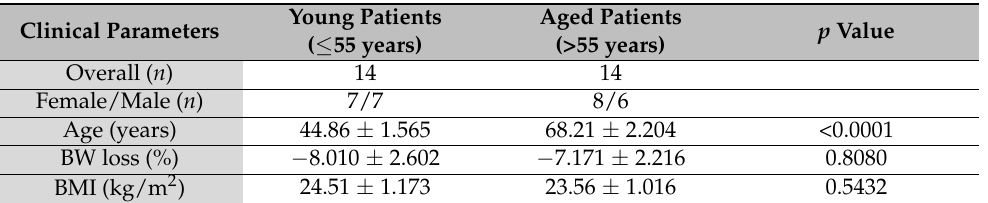
Table 3. Human clinical data. BMI: body mass index; BW: body weight. Data are mean ± s.e.m. Statistical analyses were performed with unpaired t -test or Mann-Whitney